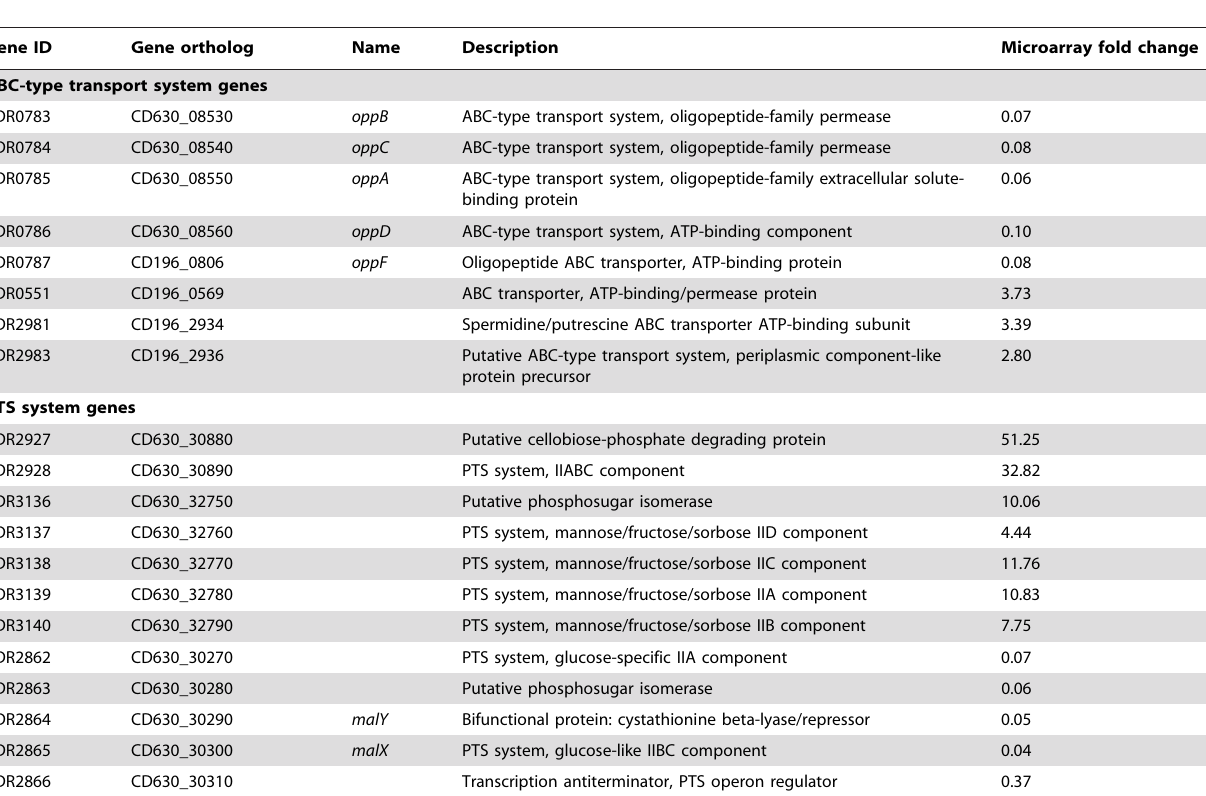
Table 2. Membrane transport genes highly differentially expressed in vivo in the fliC mutant compared to strain R20291.